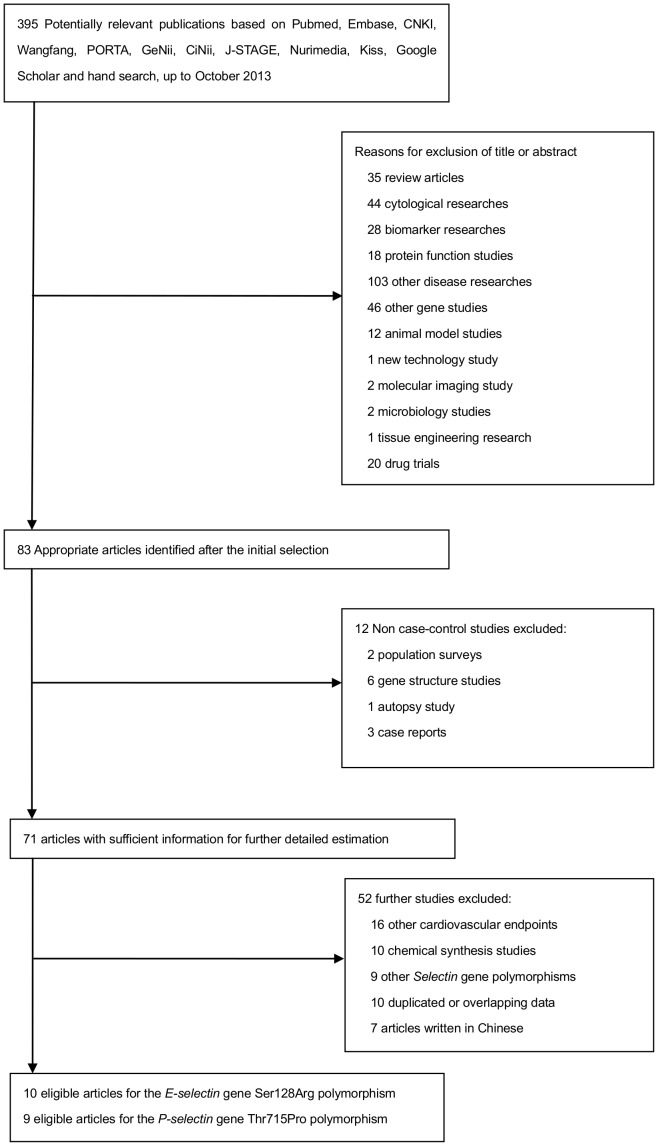
Flowchart diagram illustrating search strategy and study selection.